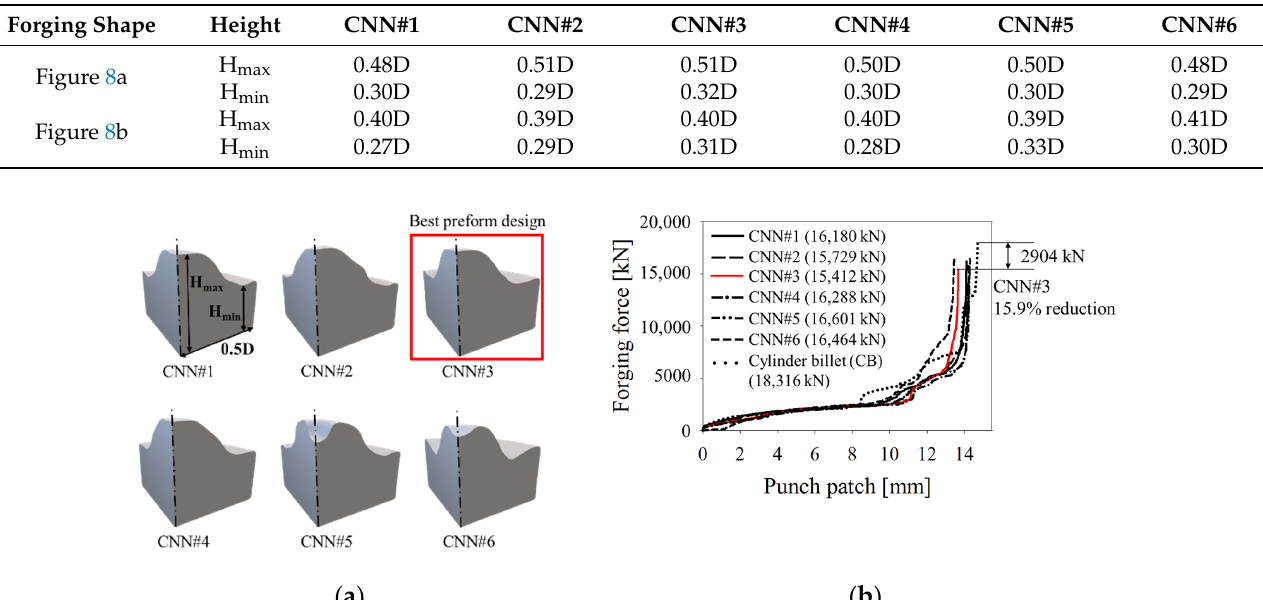
Figure 9. ( a ) Preform geometries and ( b ) forging force–punch patch curves computed for each of the CNN sub-models (including the cylindrical billet) for the forgings of Figure 8a.